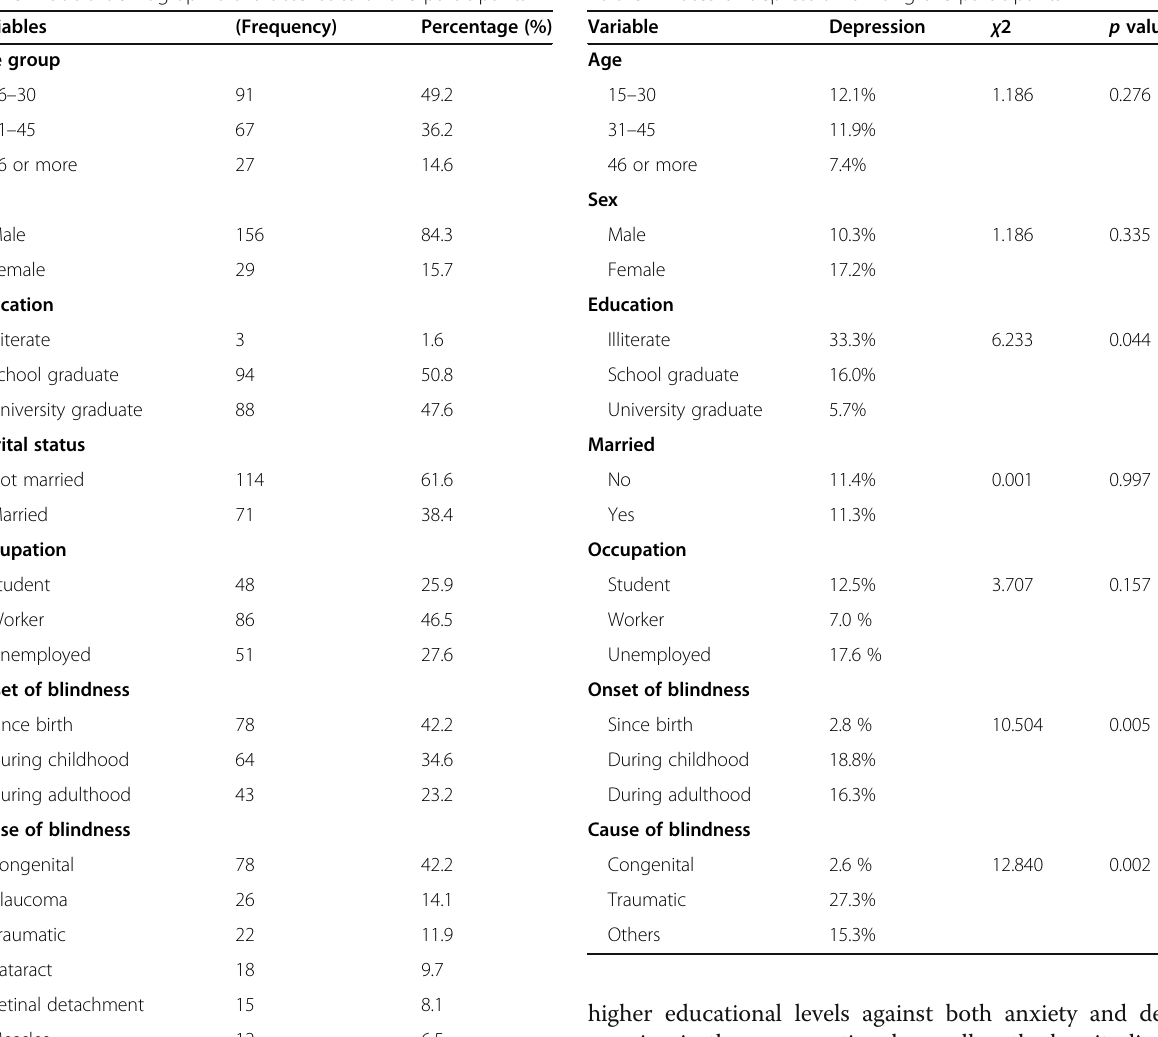
Table 2 Rates of depression among the